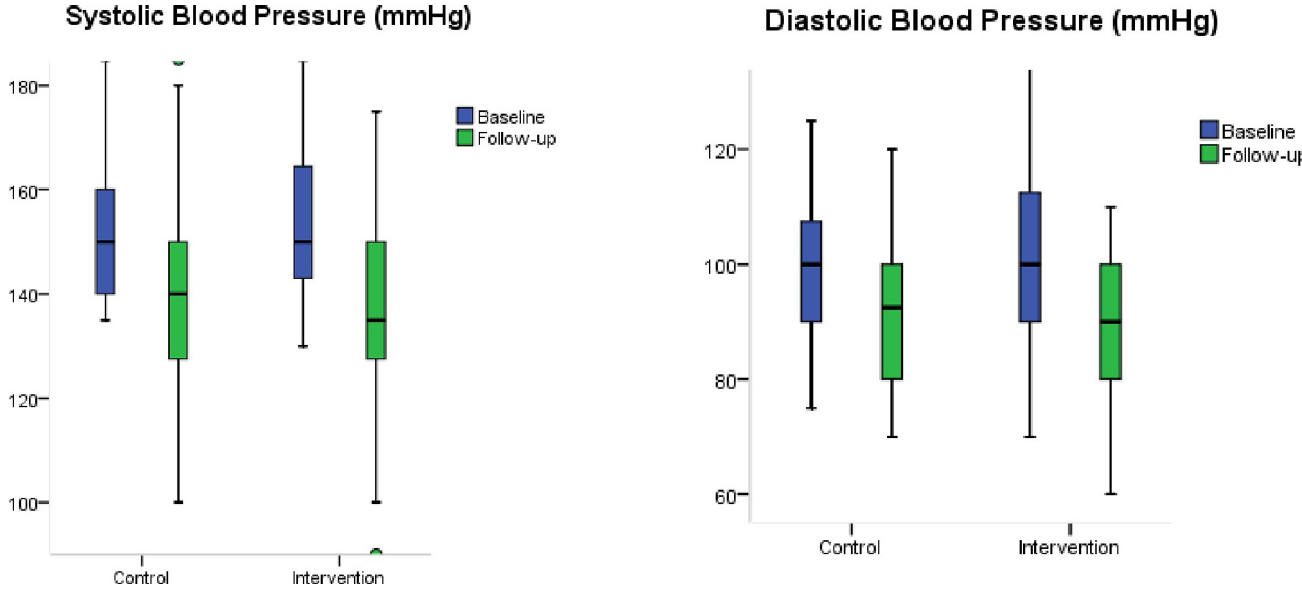
Fig 2. Box-plot of mean SBP and DBP of intervention and control